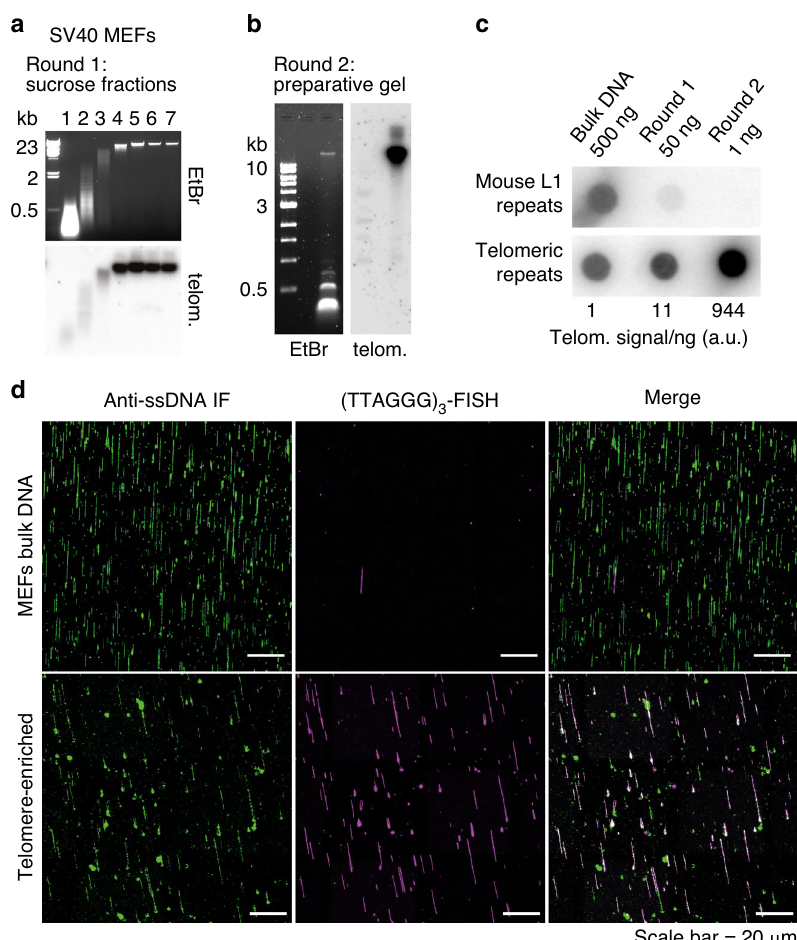
Fig. 1 A two-step procedure for the puri fi cation of mammalian telomeres. a Top: agarose gel showing the separation of the large telomeric